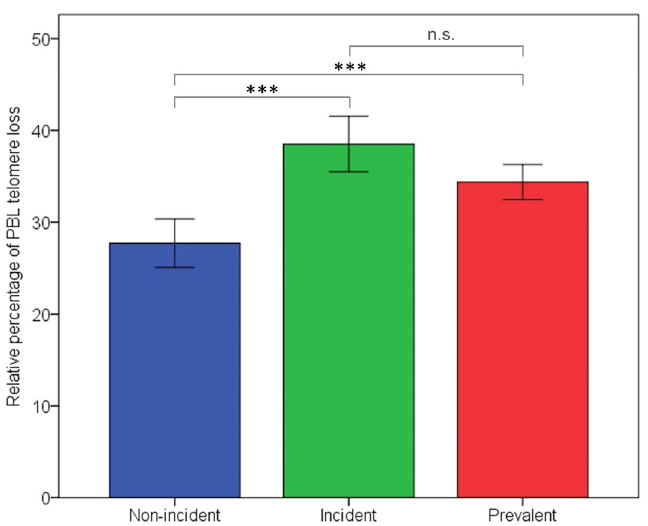
Figure 1. Rate of PBL telomere loss in prevalent, incident and non-incident knee OA. Kruskal–Wallis test evidenced significant differences among the three groups (p < 0.001). Incident knee OA exhibited a higher relative fraction of PBL telomere loss in comparison to non-incident OA (mean: 38.51 vs 27.70, Mann–Whitney U-test, p < 0.001). Magnitude of dynamic loss was not significantly different between patients with incident and prevalent knee OA (mean: 38.51 vs 34.37, Mann–Whitney U-test, p = 0.142). (Significance p value: *** < 0.001; n.s.: not